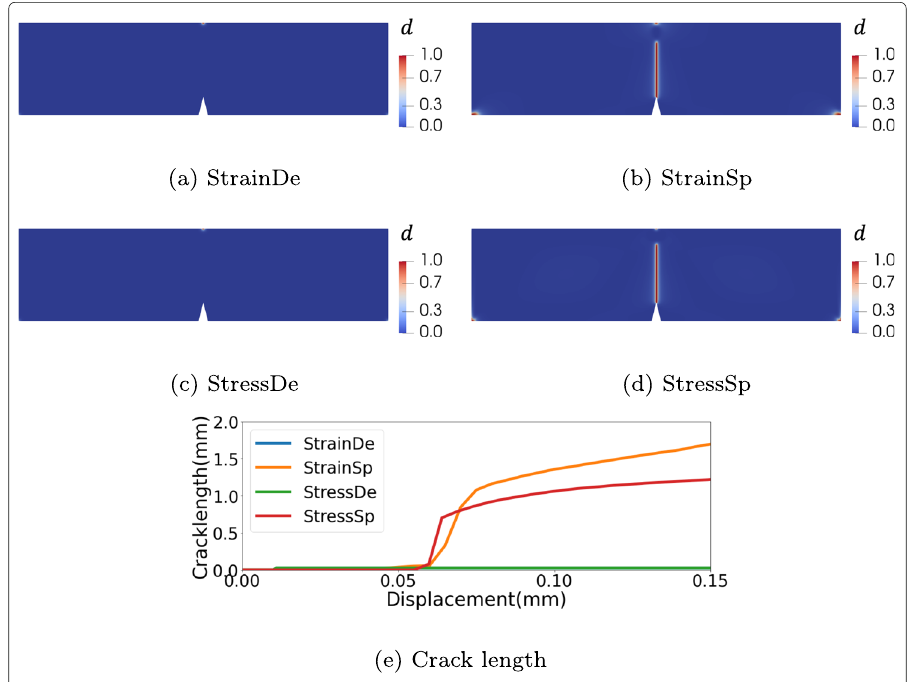
Fig. 10 Fracture results from the three-point bending simulations with the load and boundary conditions applied at a single node: ( a ) - ( d ) final crack paths for the strain deviatoric, strain spectral, stress deviatoric, and stress spectral methods, respectively. ( e ) crack length evolution for the four